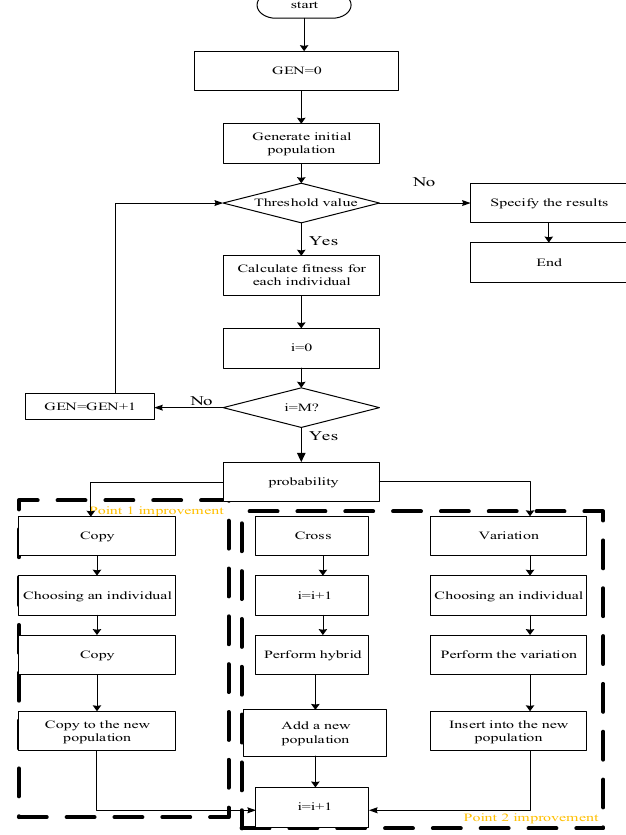
Figure 7. Traditional and improved PSO